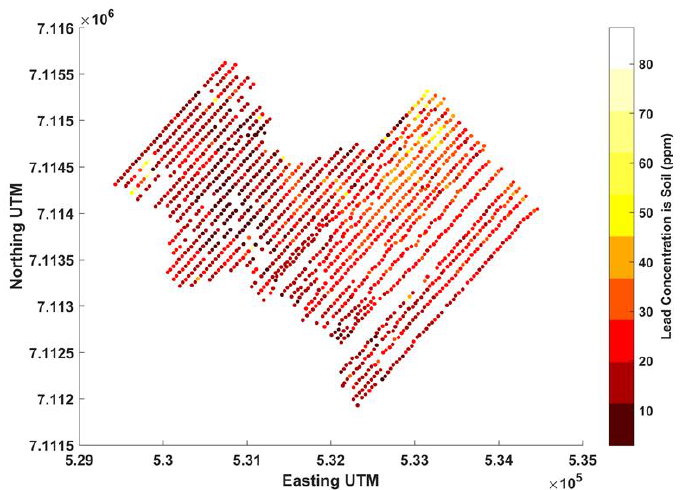
Figure 4. Spatial expression of the data used for this research, Datum: NAD83, UTM Zone 8, Eastern Yukon Territory. Yukon